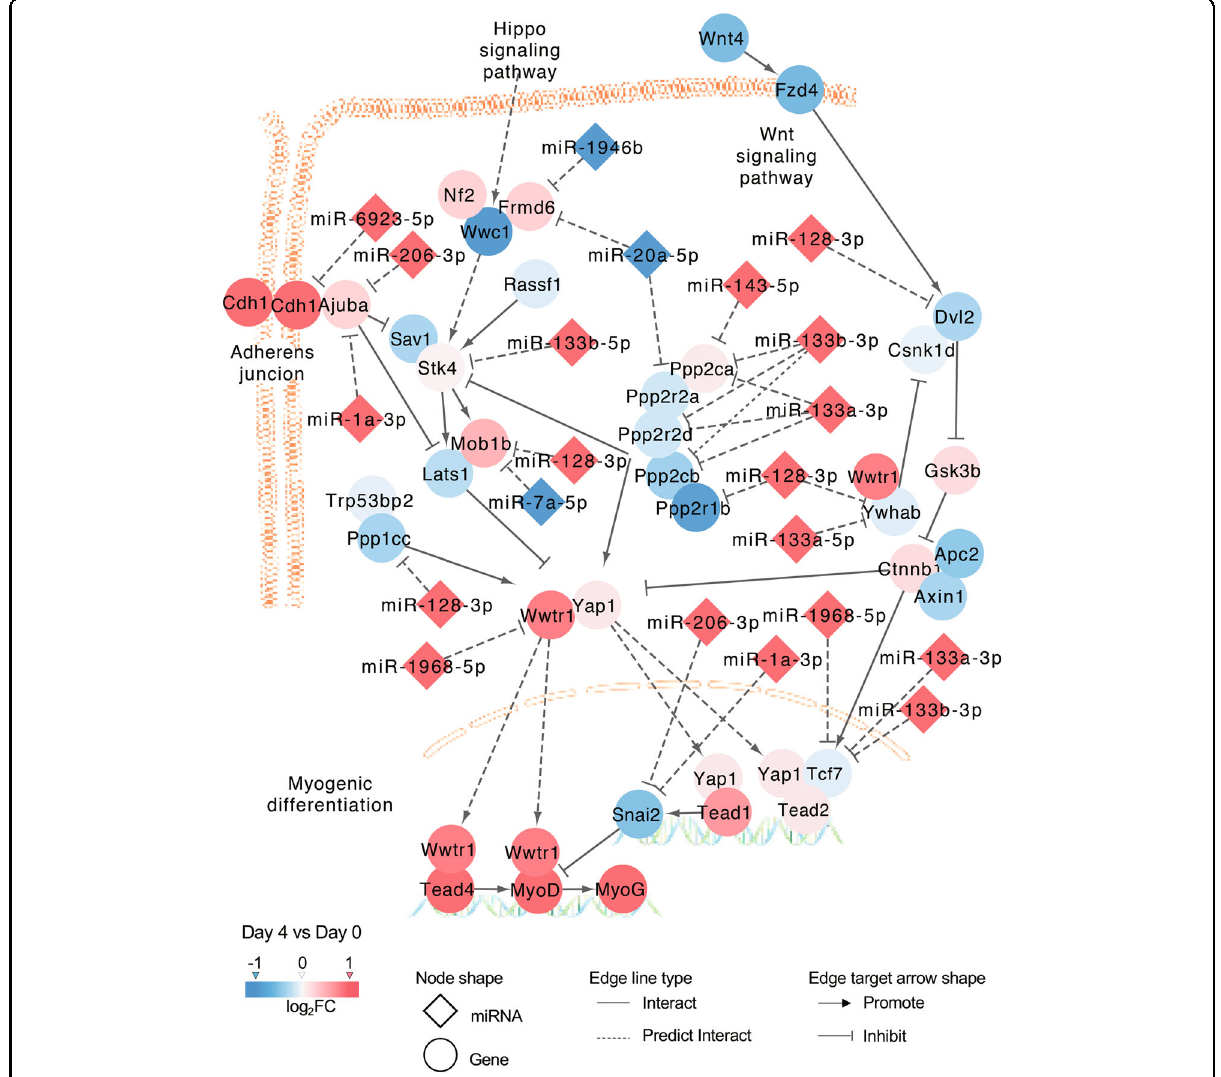
Fig. 4 Differentially expressed miRNAs involved in the Hippo signaling pathway and their target genes. Orange red and light red indicate upregulation on day 4 compared with day 0 (orange red, log 2 FC > 1; light red, 0 < log 2 FC < 1), whereas blue and light blue indicate downregulation over this same period (blue, log 2 FC < − 1; light blue, − 1 < log 2 FC <